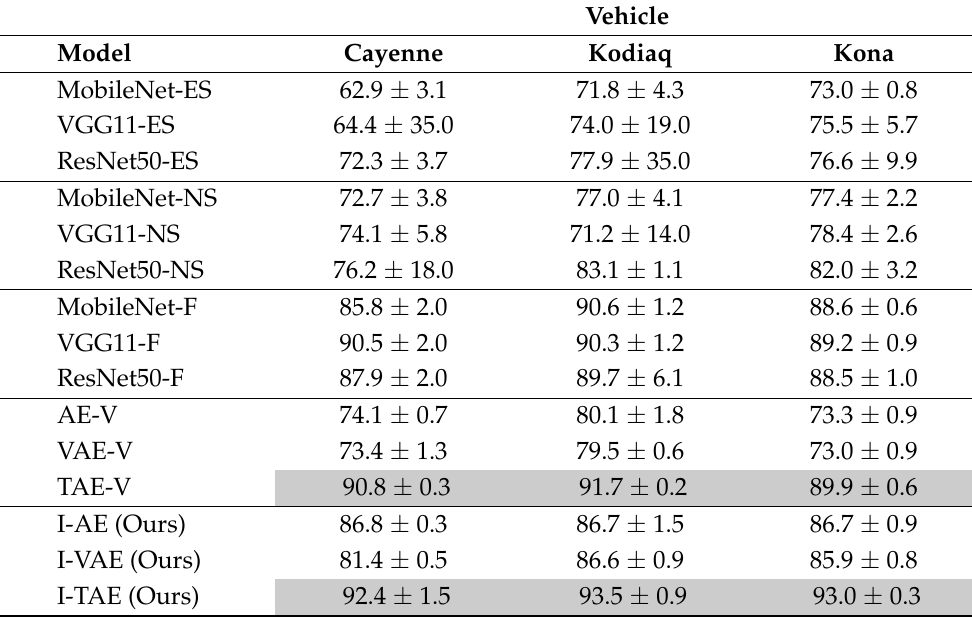
Table 2. Mean accuracy and variance over 5 repeated training runs on each of the three vehicle interiors. F—fine-tuned pretrained model, ES—early stopping with 80:20 split, NS—no early stopping and V—vanilla reconstruction loss. We either used the triplet loss (TAE), the second variation of the PIRL (II-AE) or just the vanilla reconstruction loss (AE). PIRL improves the vanilla version and, with the nearest neighbour search, outperforms all other